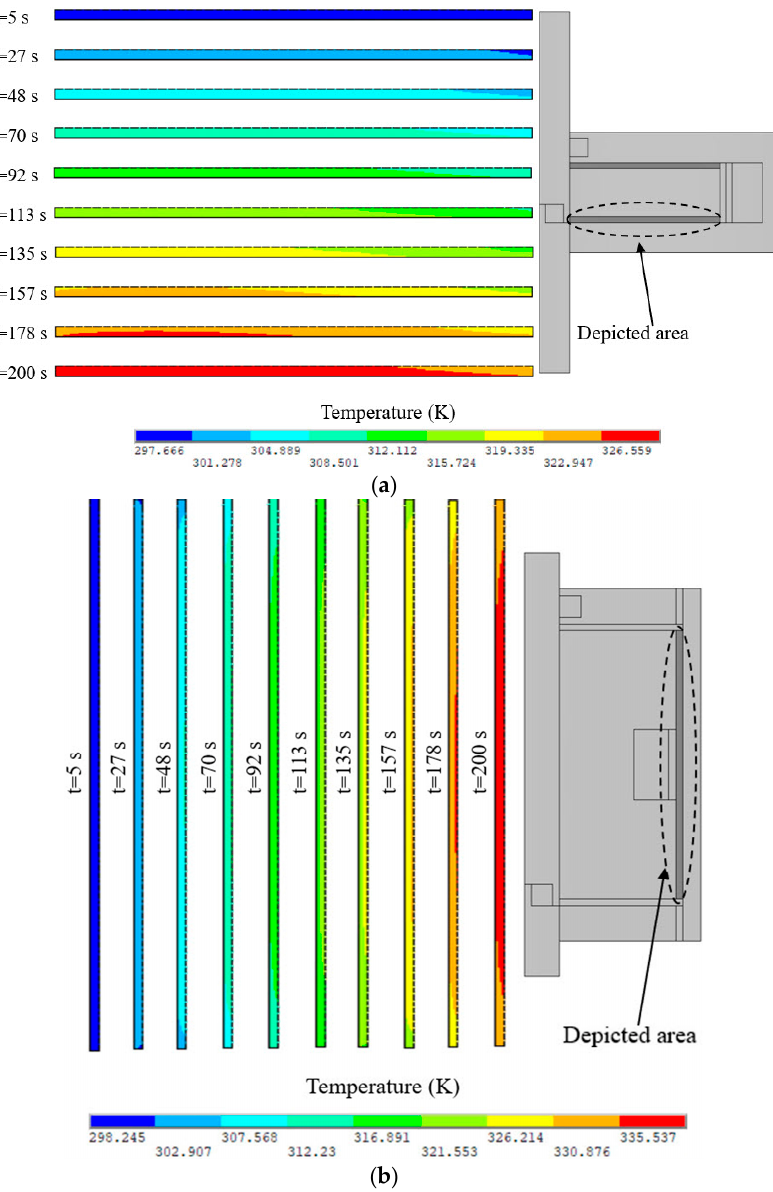
Figure 7. Temperature distributions of the working MRFs of the clutches under different slip times: ( a ) Disc ‐ type MRC; ( b ) Cylinder ‐ type MRC.